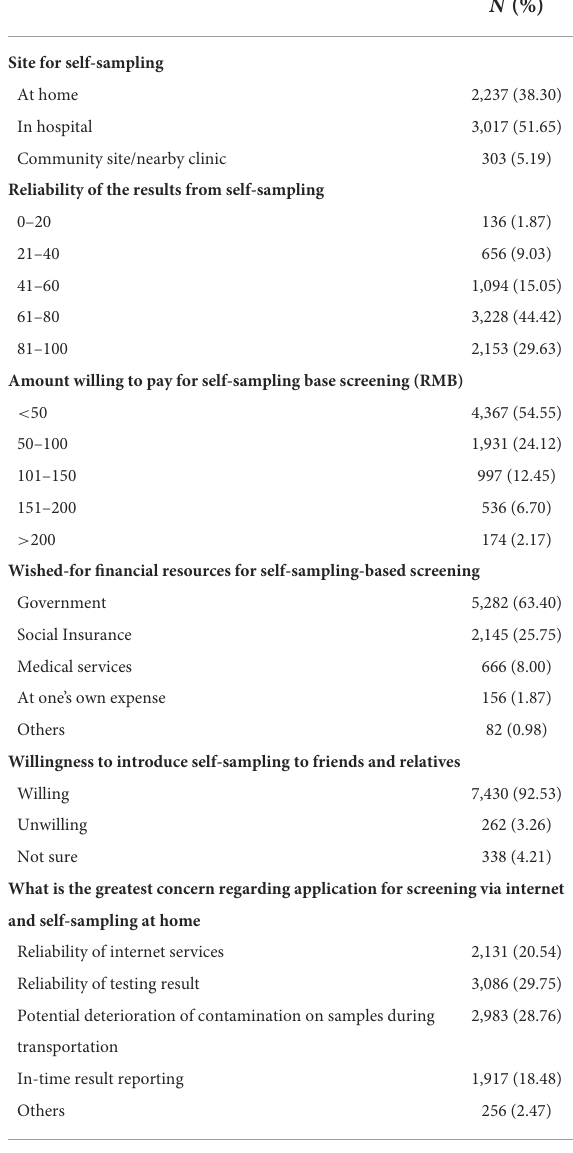
TABLE 3 Participant’s stated reasons for choosing